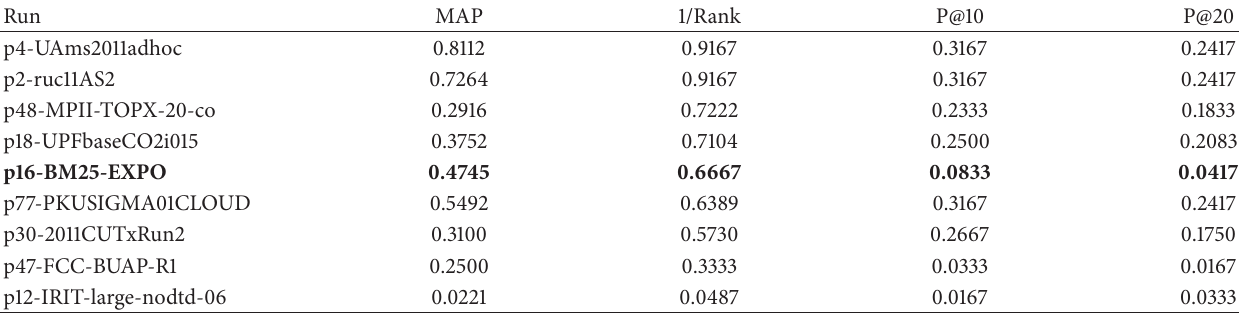
Table 8: Best performing runs based on 1/Rank over the known-item